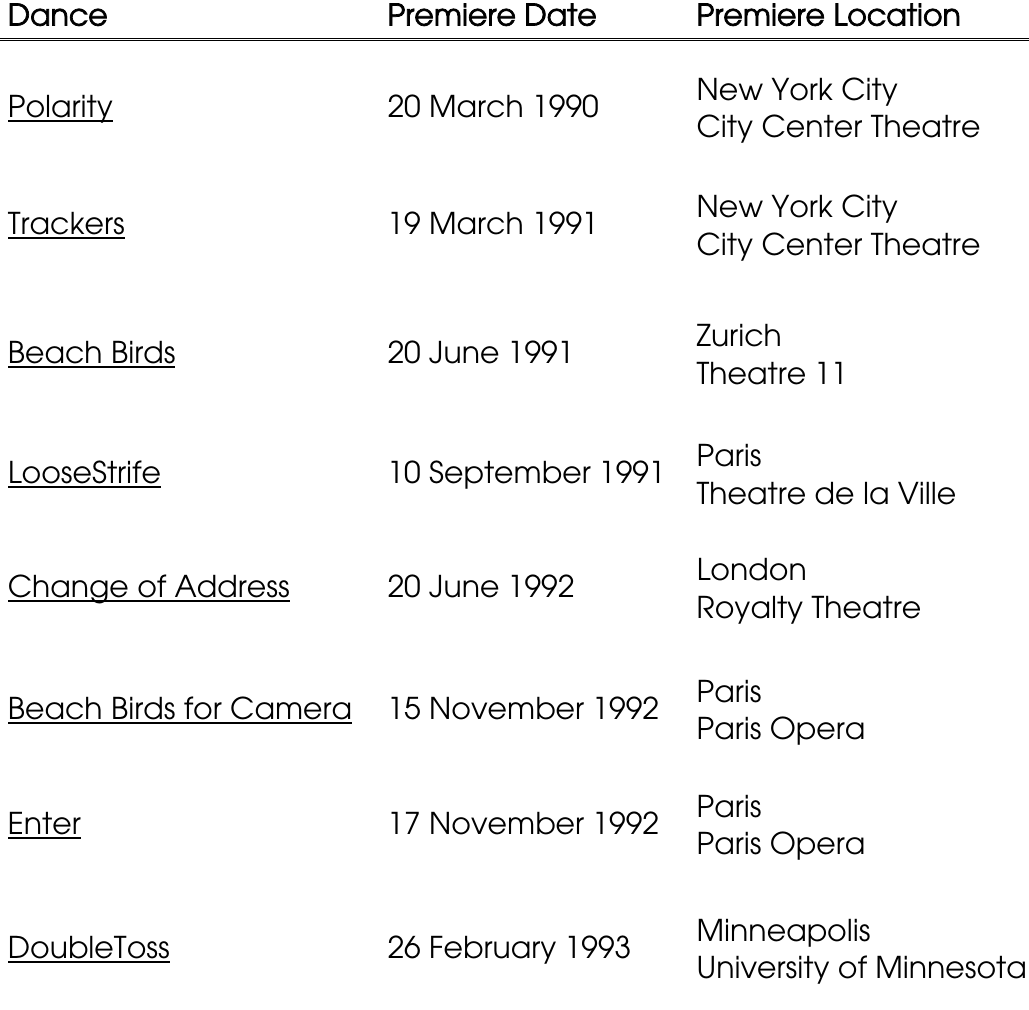
Figure 5.1. Cunningham Choreography Produced with